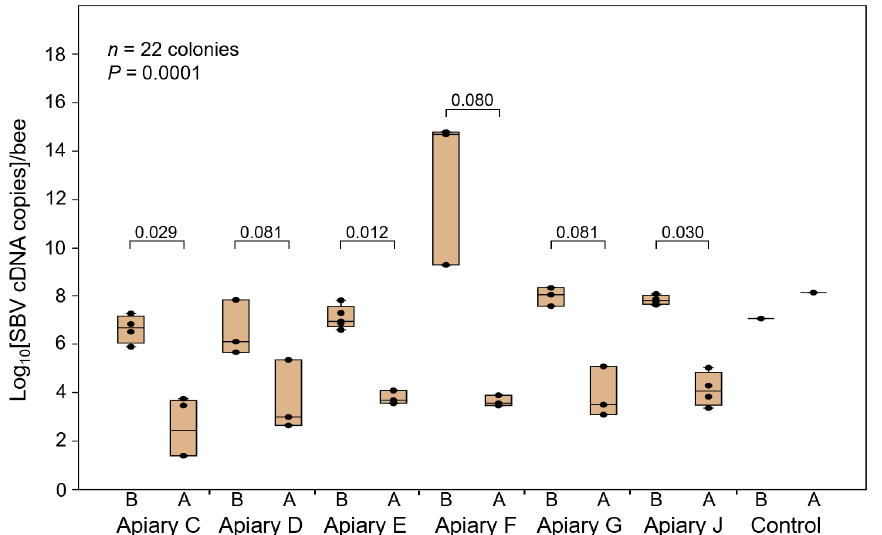
Figure 3. Relative SBV levels in double-stranded RNA (dsRNA) treatment apiaries. A total of 22 colonies from six randomly selected apiaries (apiaries C, D, E, F, G, and J) out of the 78 dsRNA- treated colonies belonging to 17 apiaries were quantitatively assessed for SBV levels before and after